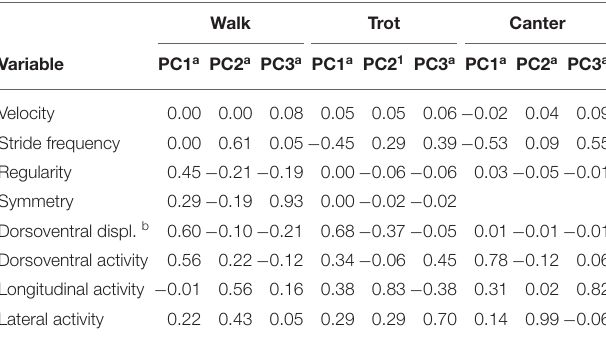
TABLE 1 | Eigenvectors of the principal component analysis of the standardized variables derived from accelerometric analysis of gaits. Walk Trot